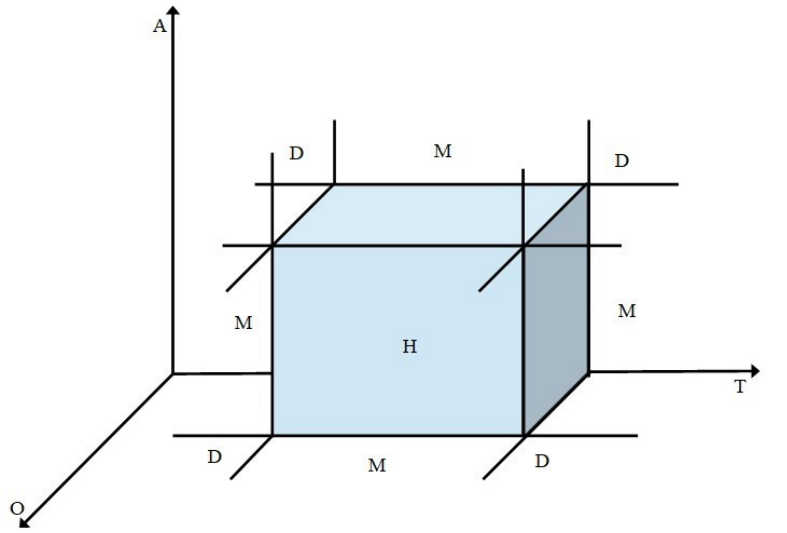
Figure 3. Region H: Only healthy subjects; Region D: Only depressed subjects; Region M: Overlap- ping